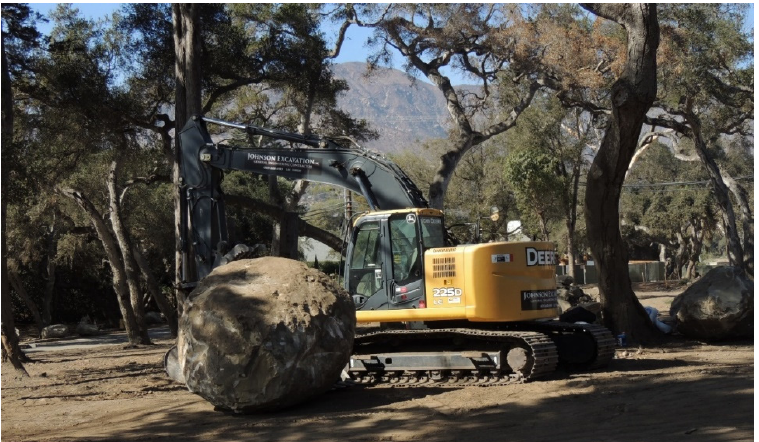
Figure 8. Boulder transported by Montecito debris flow that is larger than the local channel dimensions (max clast size/channel width >1).